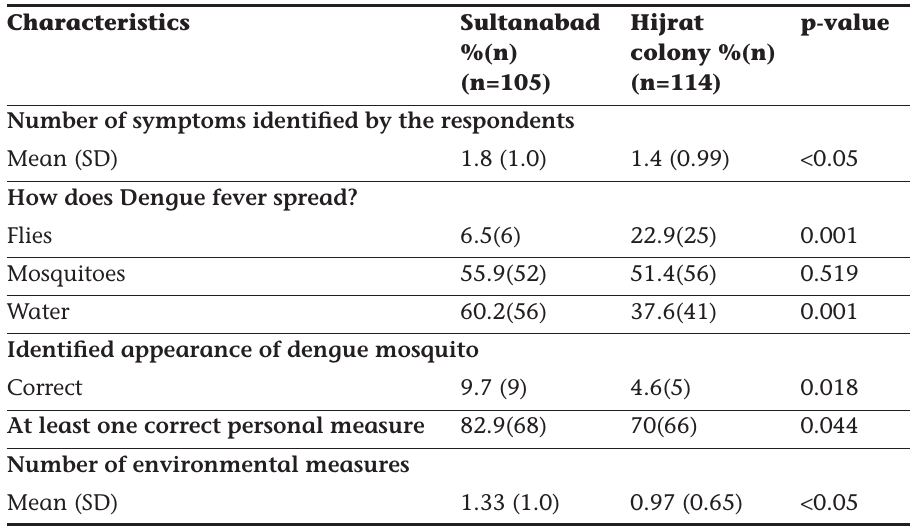
Table 1: Comparison of knowledge regarding